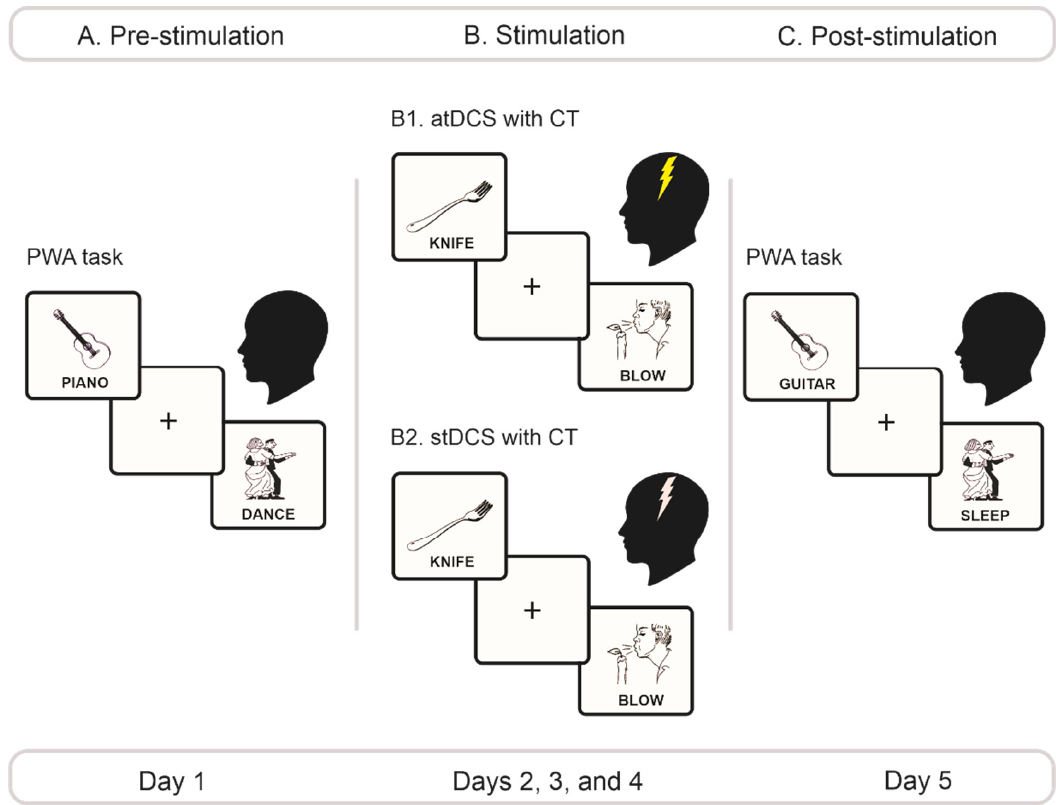
Figure 1. Experimental protocol. ( A ) Pre-stimulation phase. On day 1, we administered the PWA task, counterbalancing the order of the action-verb and the object-noun conditions across patients. ( B ) Stimulation phase. From days 2 through 4, depending on their group, patients underwent either atDCS (B1) or stDCS (B2) of the left M1 region during 20 min. Stimulation was applied with an intensity of 2 mA for the atDCS group and 0 mA for the stDCS group. Each day, during stimulation, they performed counterbalanced versions of the PWA task with stimulus sets that differed from those employed in the pre- and Ppost-stimulation phases. ( C ) Post-stimulation phase. On day 5, we repeated the same exact procedure of day 1, with stimuli from the PWA task presented in a new pseudorandomized order. PWA, picture–word association; atDCS, anodal transcranial direct brain stimulation; stDCS, sham transcranial direct brain stimulation; CT, cognitive